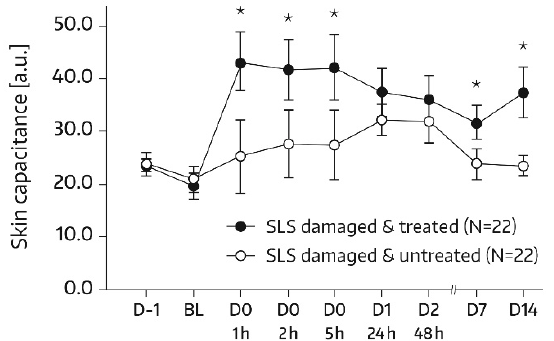
Figure 3. Results from skin capacitance measurements in untreated SLS-damaged skin and SLS- damaged skin undergoing a single application of Emollient 1 (first 48 h) followed by once-daily application for 12 days. The values were assessed by corneometry and are presented as mean ± SD. SLS challenge started on day -1 and ceased 24 h later (30 min before BL assessment). BL = Baseline skin capacitance value before first product application; D = day; h = hour; SLS = sodium lauryl sulfate.* p < 0.001 if compared to untreated control, paired t -test.